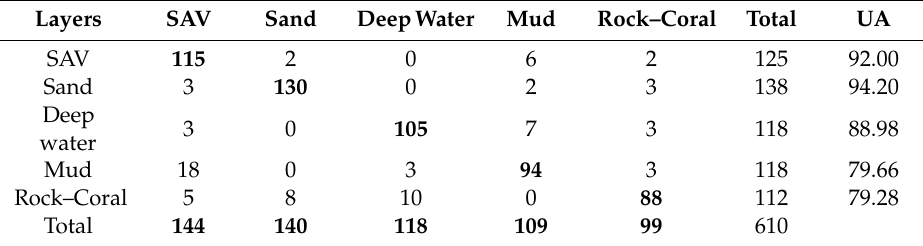
Table A4. Sentinel-2 confusion matrix table